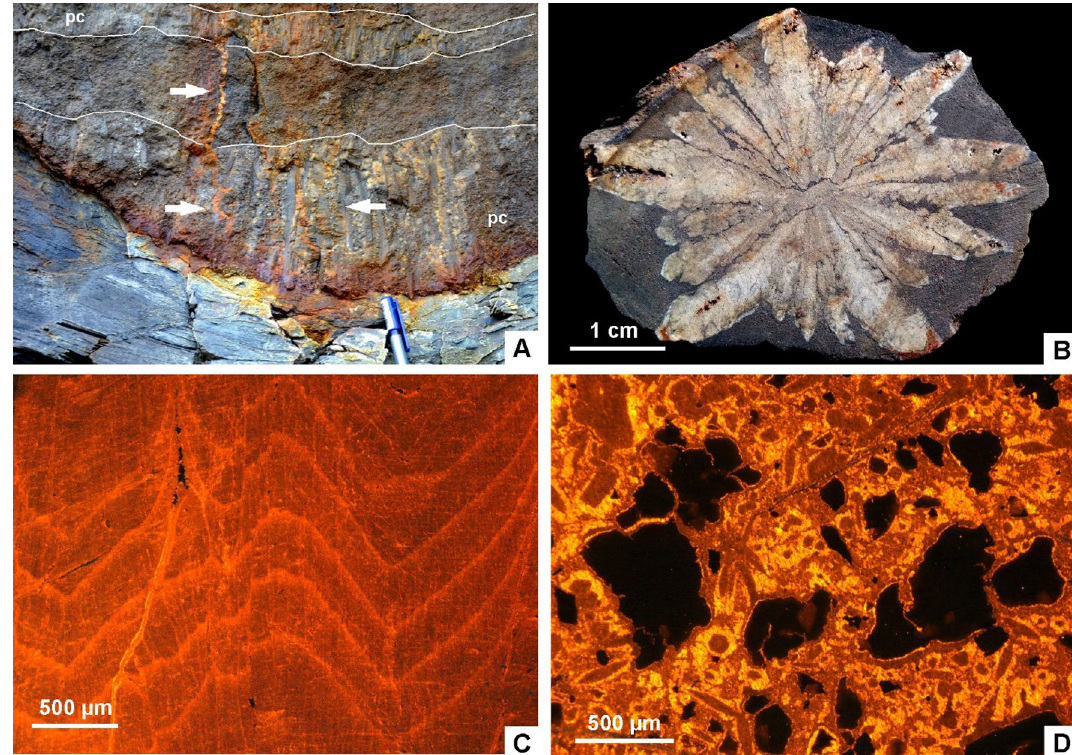
Figure 5. (A) Superposition of palisade crusts (pc) in the basal part of the Kakeled Limestone Bed at Bruddesta with arrowed polymetallic veins. ( B) Slab of a glendonite rosette embedded in the black shale interbeds separating the Exporrecta Conglomerate and Kakeled Limestone beds at Degerhamn. ( C) Cathodoluminescence thin-section photomicrograph showing the core of a glendonitic aggregate, with zoned dull-orange luminescence, displaying the prismatic chevron-like habit of stellate pseudomorphs. ( D) CL photomicrograph of a lag accumulation showing a mixture of non-luminescent (polymetallic sulphides) and dull-brownish luminescent glendonitic clasts embedded in a brightly yellowish